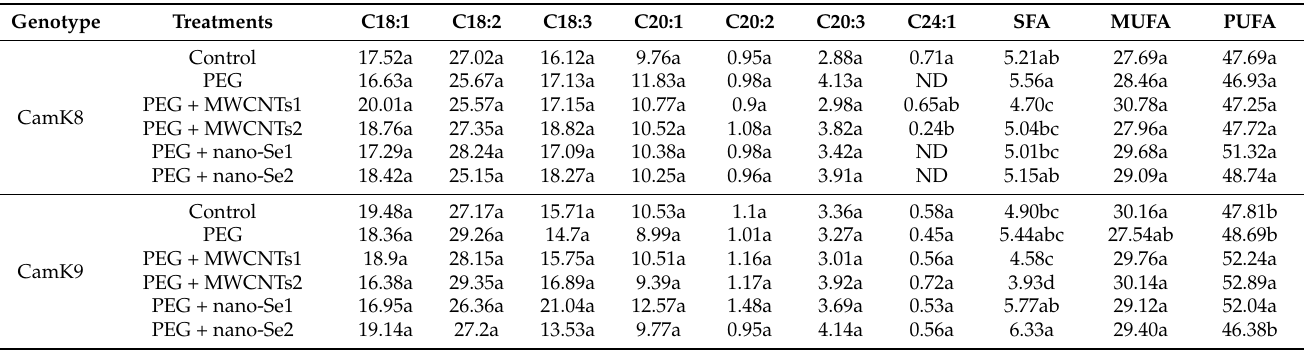
Table 2. Principal fatty acid composition and fatty acid groups (% of total fatty acids) of CamK8 and CamK9 under various